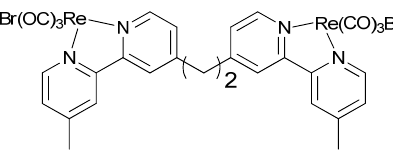
Figure 7. Binuclear